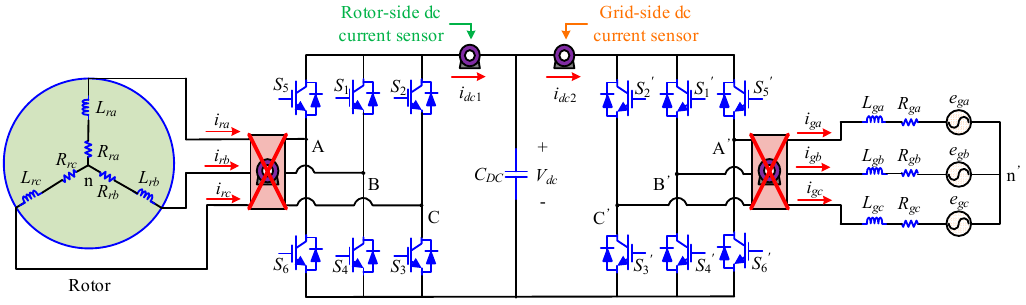
Figure 3. DC-link current sensor based phase current reconstruction strategy for back-to-back (BTB) of DFIG-WT.